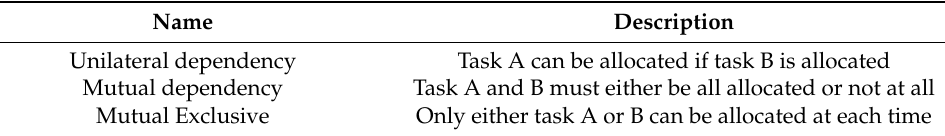
Table 1. Spatial coupled constraints in CCBBA.